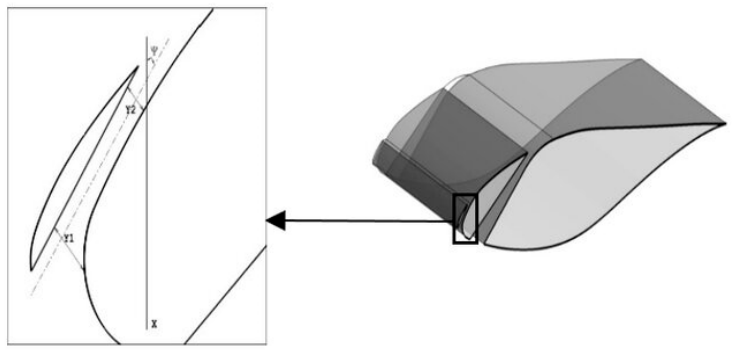
Figure 12. Comparative view of streamlines and velocity distributions for configurations 1 and 2 at r/R = 0.2 and U ∞ = 16 m s − 1 .